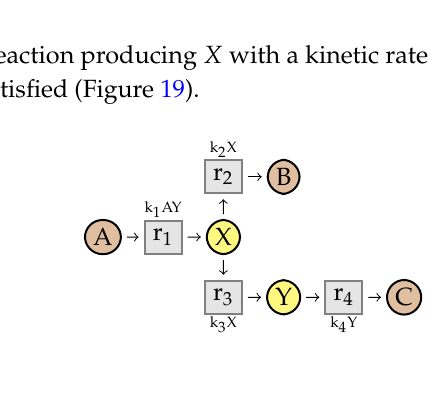
Figure 19. Example illustrating the need of Condition 3.